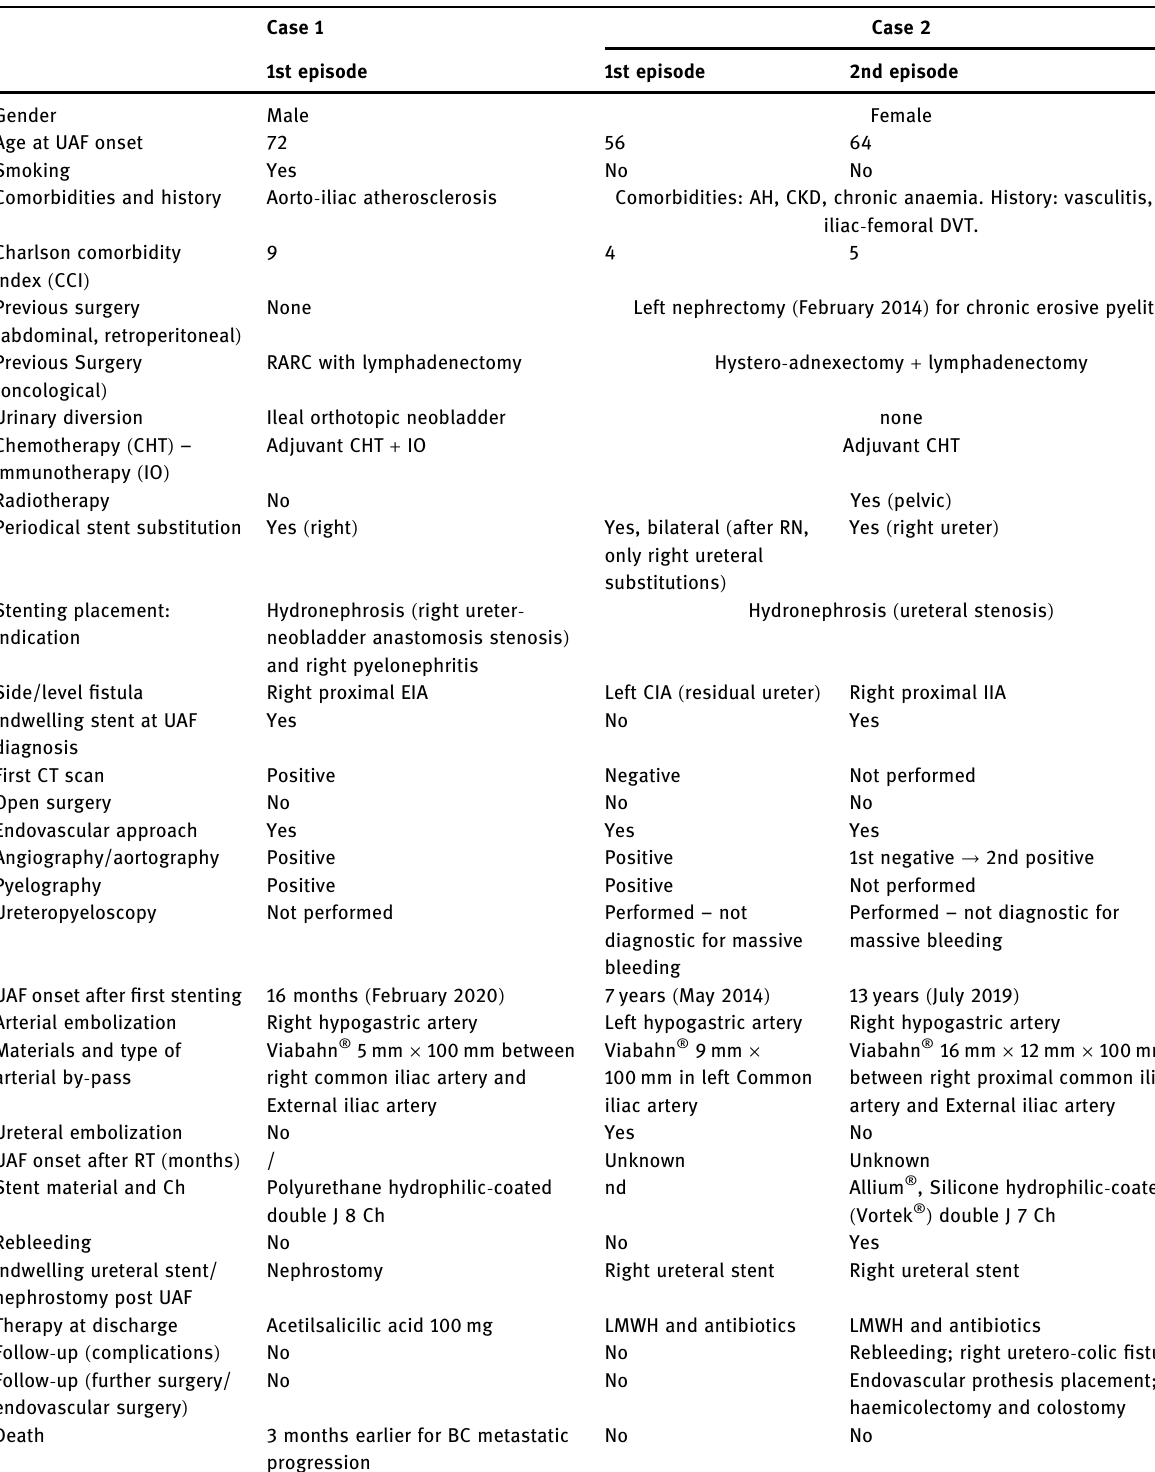
Table 1: Clinical history of our